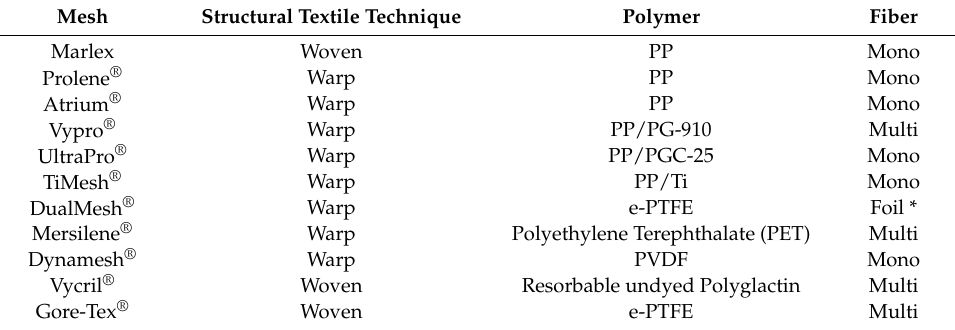
Table 4. Classification of commercially available surgical meshes